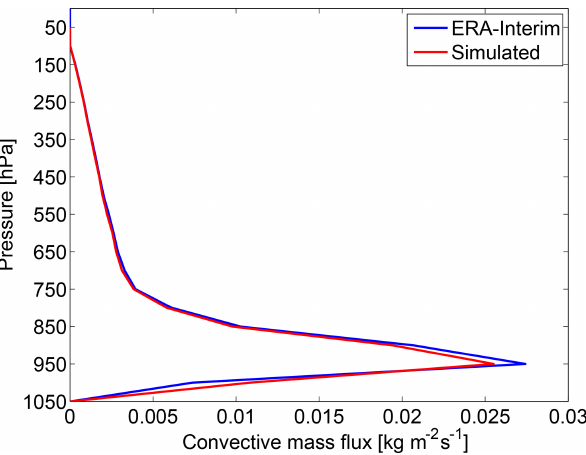
Figure 10. Mean detrainment rate profile from ERA-Interim com- pared to the simulated detrainment rate profile for forward trajecto- ries and constant convective area fraction profile (in a region from 180 to 240 ◦ E and 30 ◦ S to 30 ◦ N; 20d with meteorological fields of 1 June 2010 at